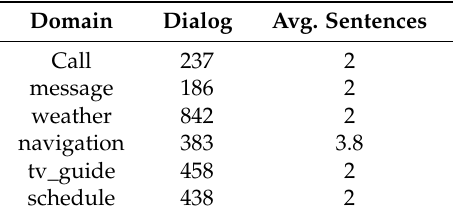
Table 1. Number of dialogs for